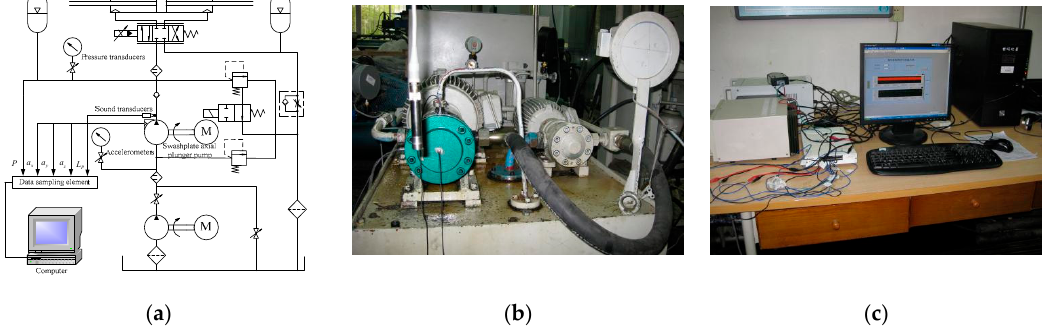
Figure 11. The experiment system of the swash plate axial plunger pump. ( a ) Schematic diagram; ( b ) swash plate axial plunger pump; ( c ) data acquisition equipment.